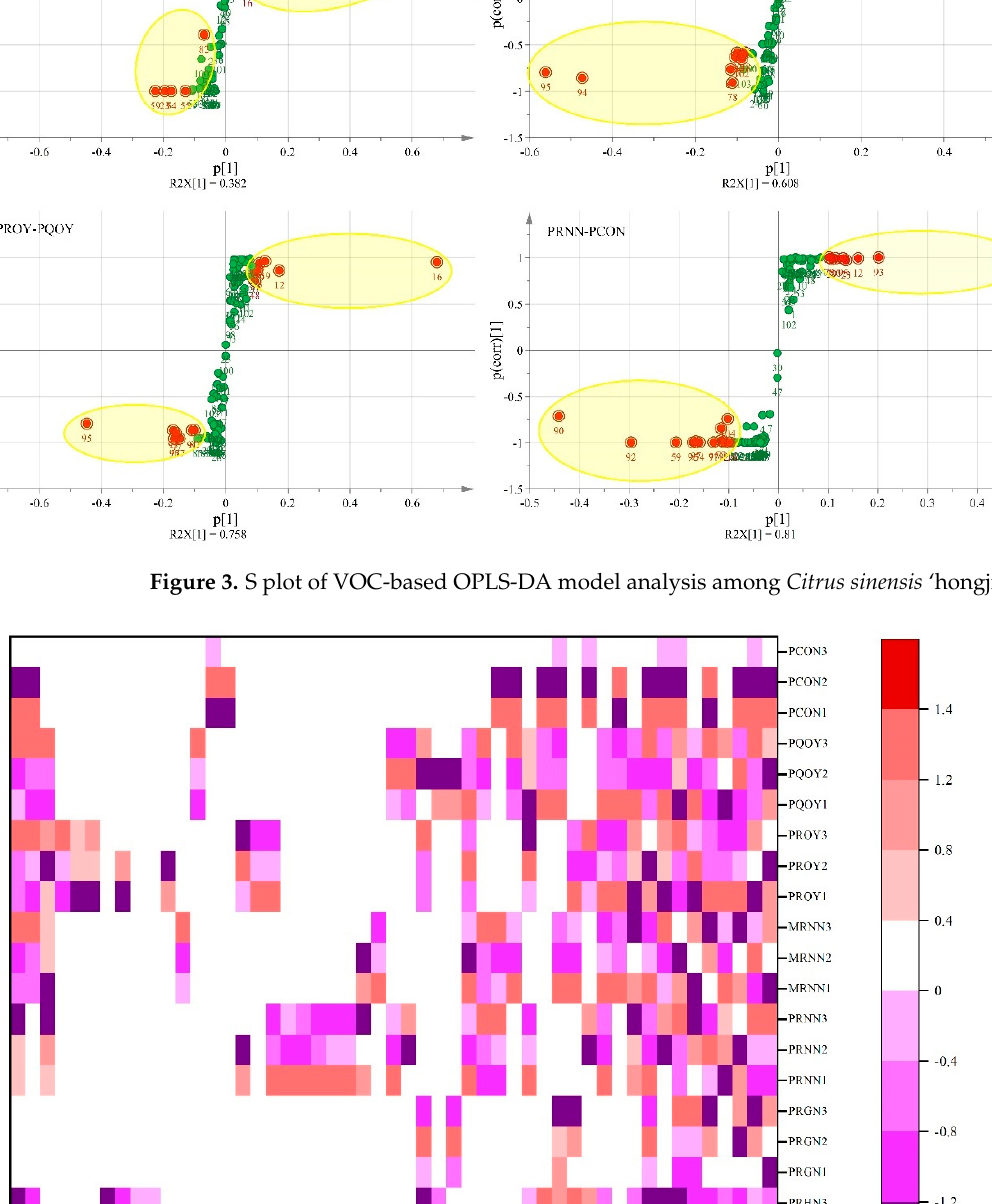
Figure 4. Heatmap of different metabolites among Citrus sinensis ‘hongjiang’.